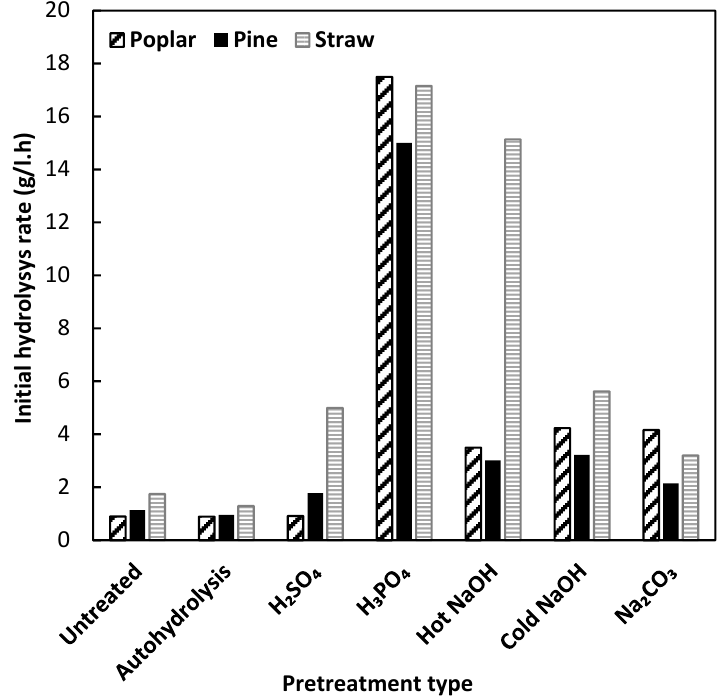
Figure 3. Initial hydrolysis rate of untreated and pretreated poplar wood, pinewood, and rice straw.